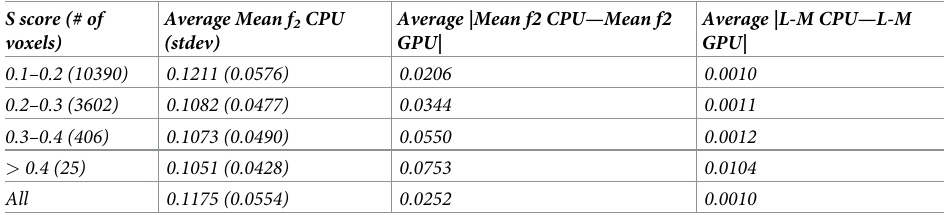
Table 2. Significantly different f 2